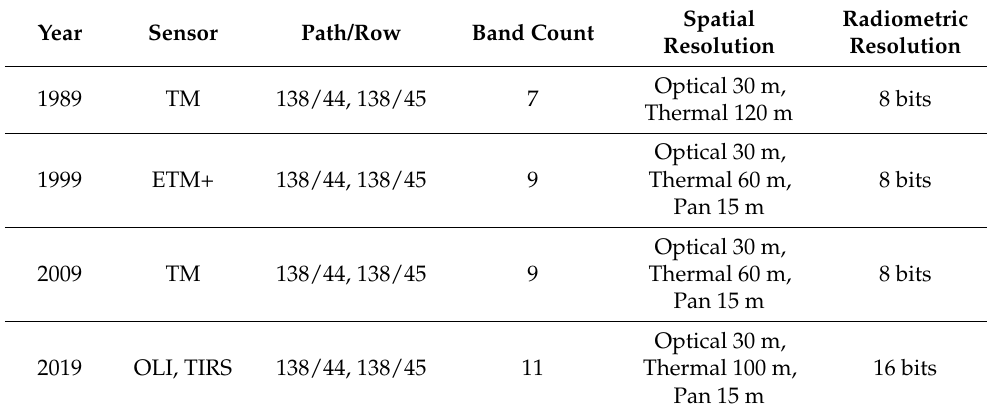
Table 1. Detailed features (i.e., metadata) of the datasets analyzed in the present case study, with different